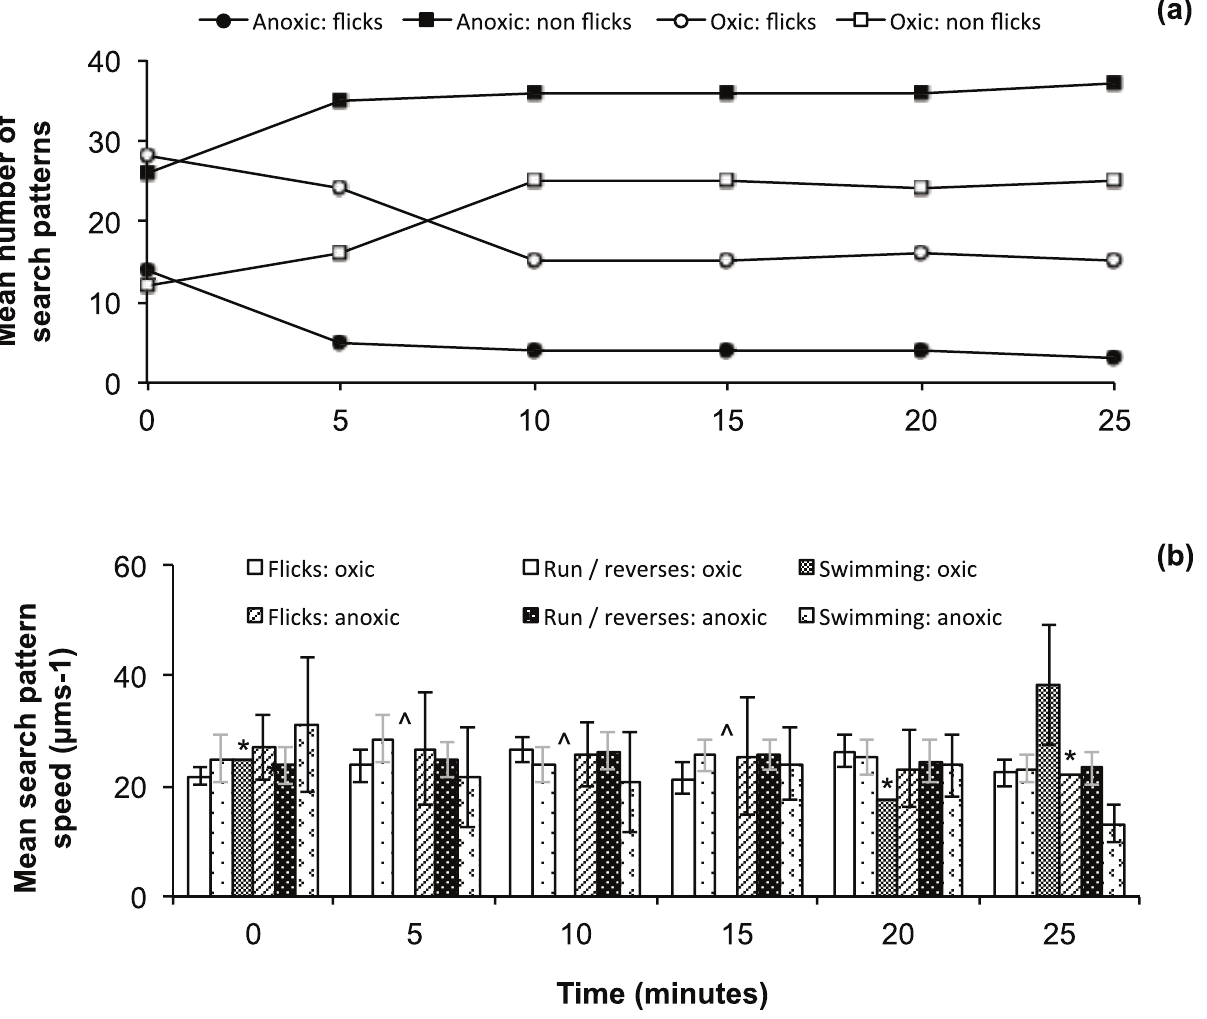
Figure S1 A sample video recording of Vibrio coralliilyticus